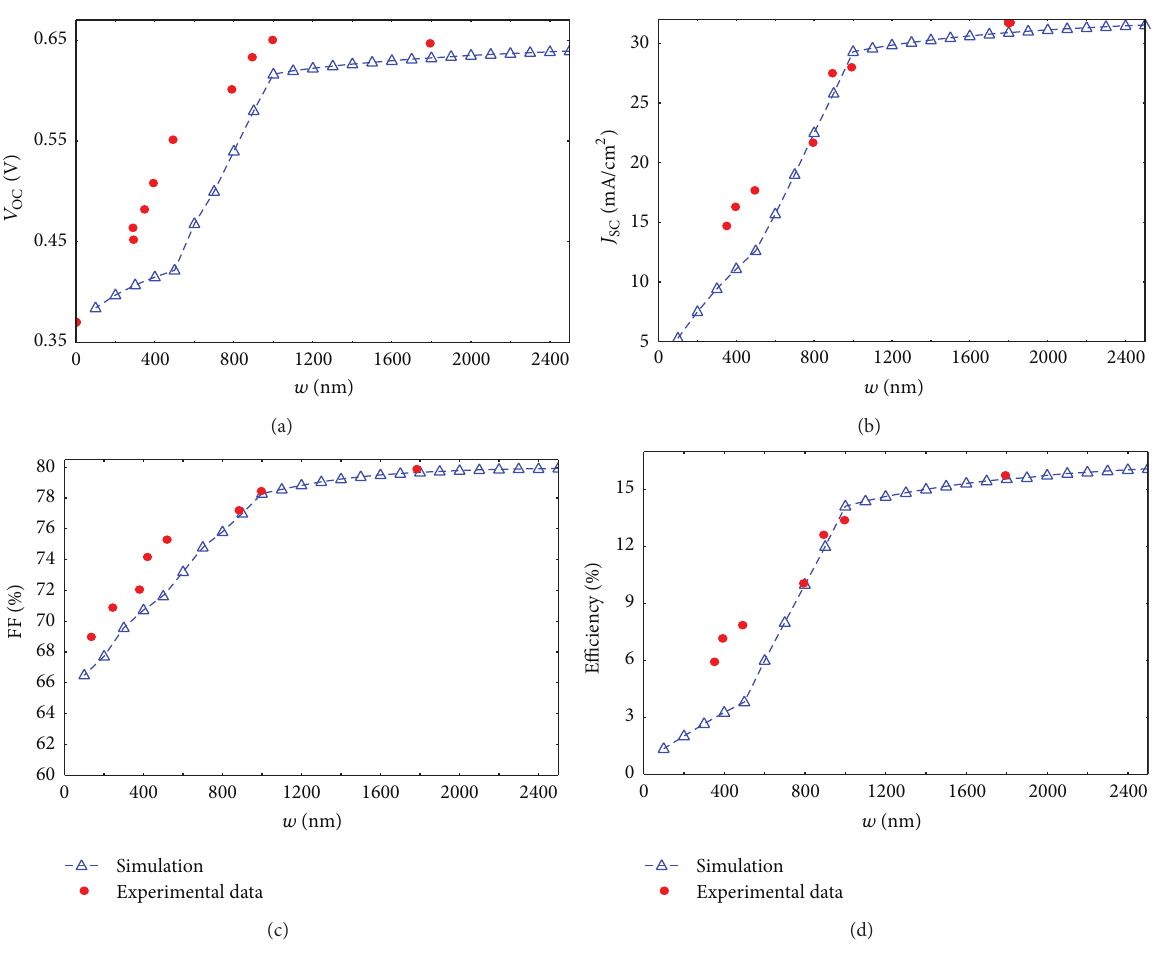
Figure 3: Absorber thickness effects on the short-circuit current density ( 𝐽 The solid red circles denote the experimental data extracted from